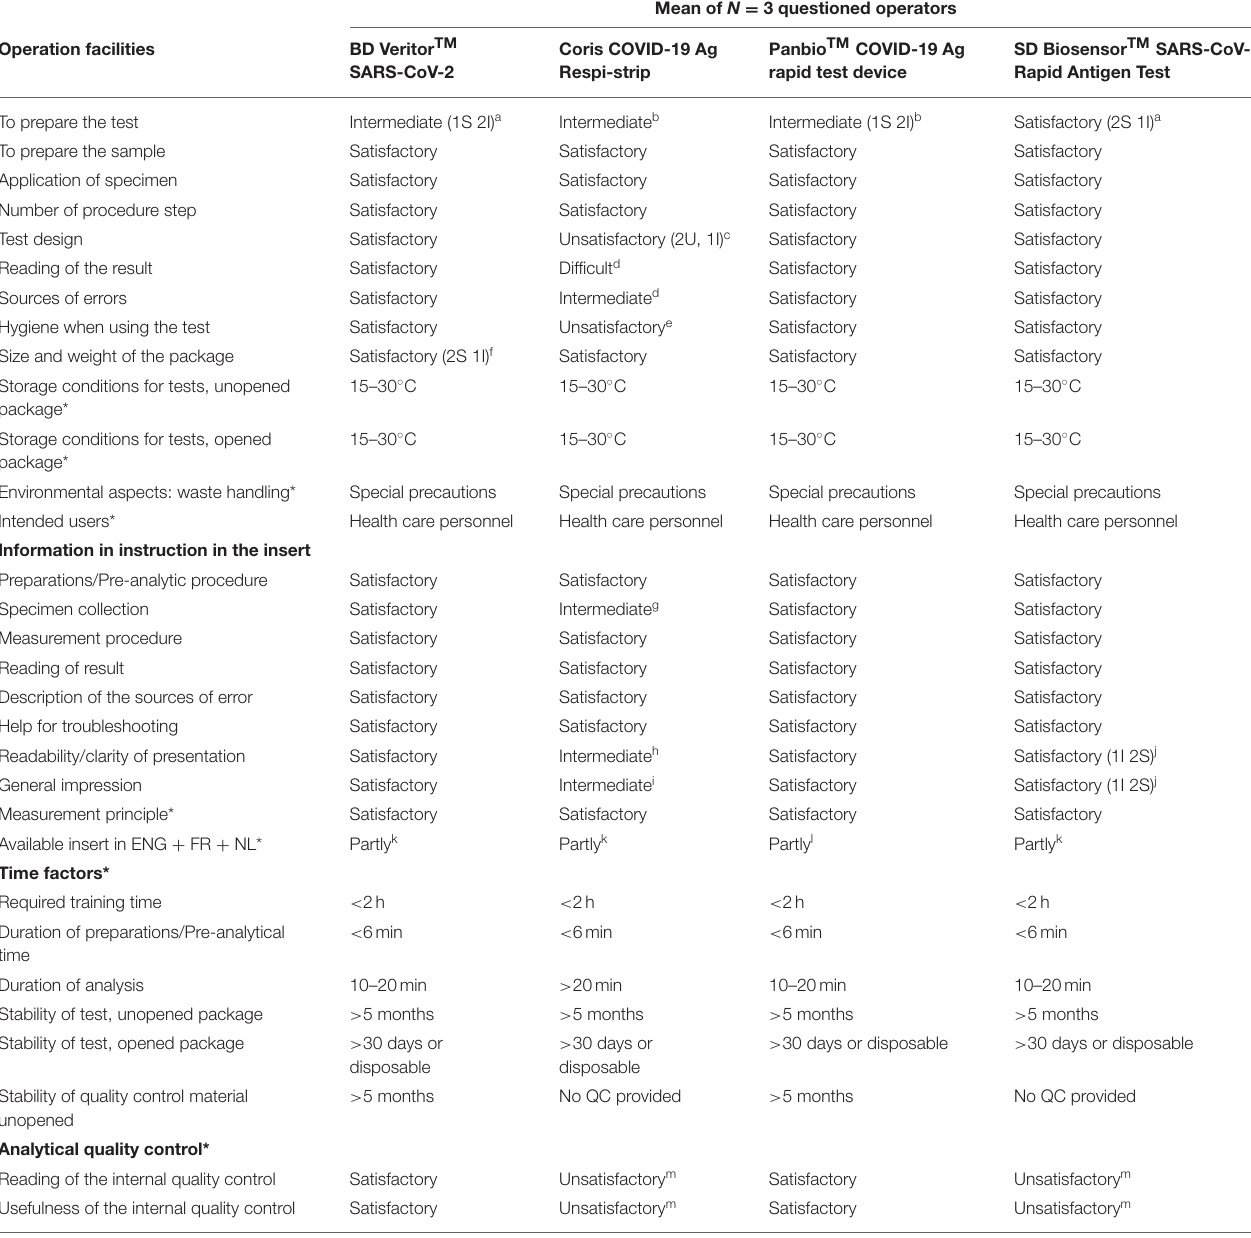
TABLE 3 | User friendliness assessment of four COVID-19 antigen rapid diagnostic tests, adapted from SKUP/2018/114